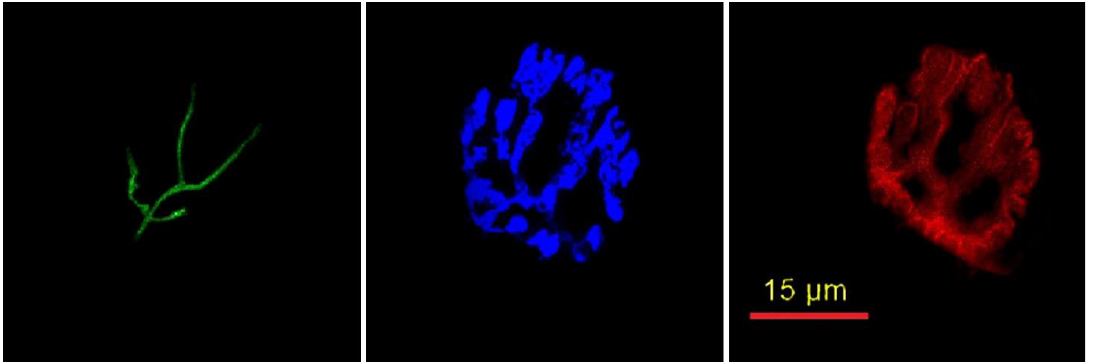
Figure 1. Representative immunofluorescent staining cellular features of the NMJ. Pre-synaptic nerve terminal branches are highlighted with AlexaFluor 488 (green), pre-synaptic acetylcholine-containing vesicles are displayed with AlexaFluor 647 (blue), and post-synaptic acetylcholine receptors are visualized with rhodamine (red).